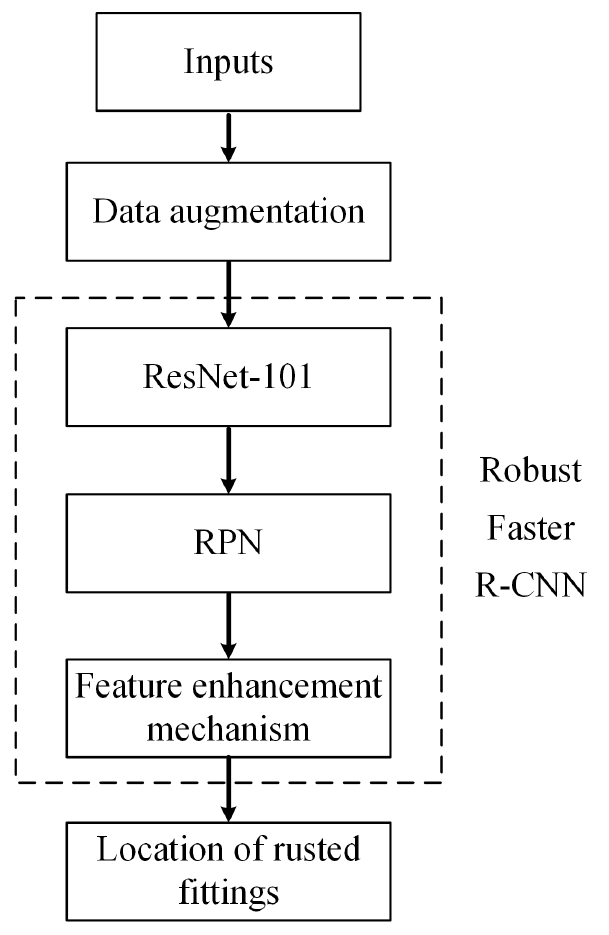
Figure 9. Flowchart of the whole